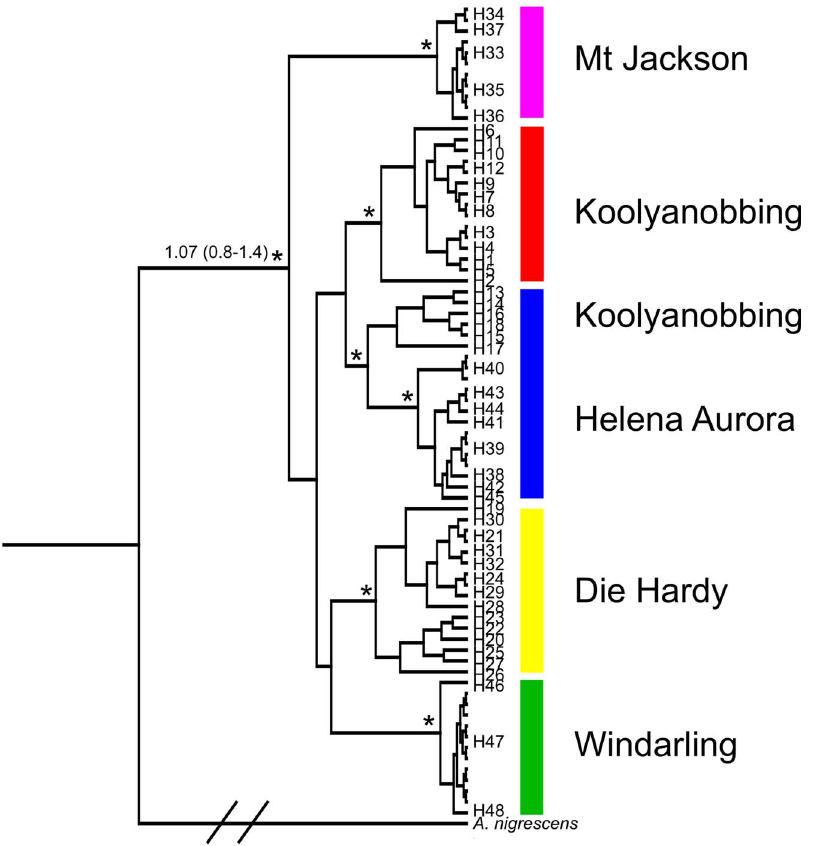
Figure 2. Bayesian cladogram of 75 Atelomastixbamfordi individuals based on combined CO1 and 16 S mtDNA data. Clades are designated separate colours as per Fig. 1. Numbers on terminals indicate haplotype number. The * denotes major nodes with high support (posterior probability . 0.85) and the numbered node indicates divergence estimate in millions of years with confidence intervals in brackets. NB the A. nigrescens branch has been truncated (//) for viewing purposes.